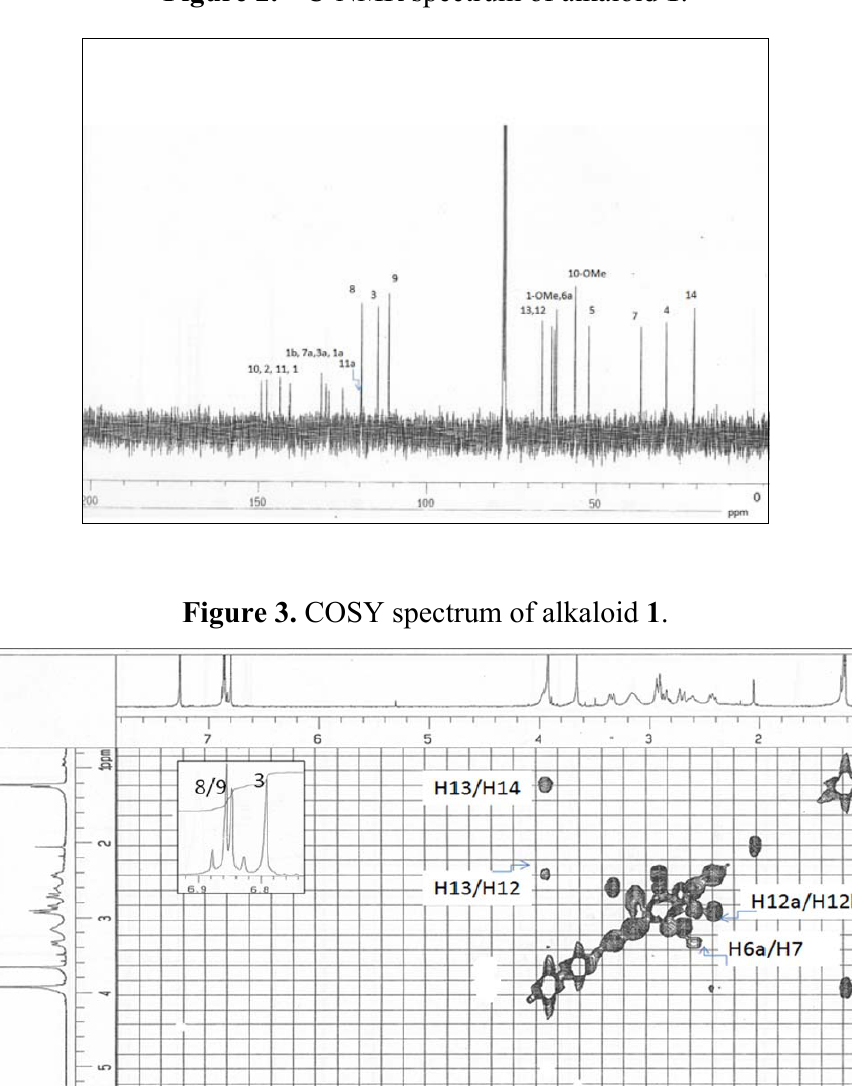
Figure 2. 13 C-NMR spectrum of alkaloid 1 .